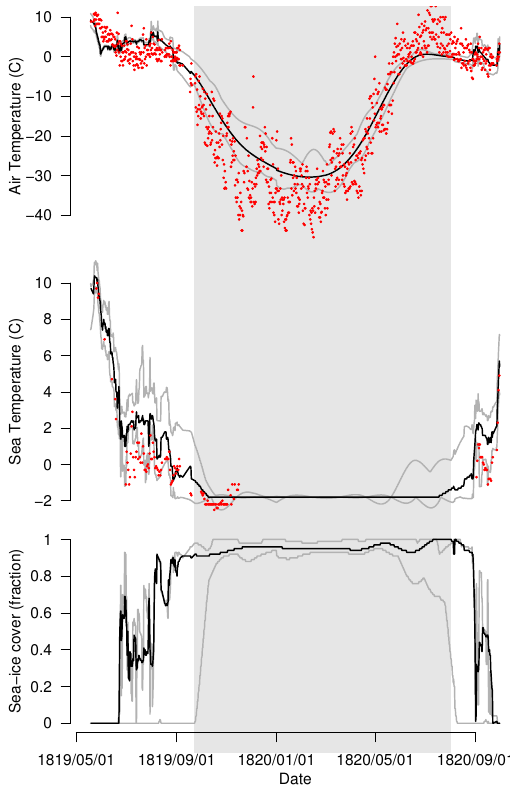
Fig.6. WeatherobservationsfromHMS Hecla in1819–20,comparedwithmodernvalues.Theredpointsaretheexpedition’sobservations, theblackandgreylinesarethemean,maxandminvaluesfrommoderndatasets(monthlyaveragesinterpolatedtodaily,1979-2004;SST Fig. 6. Weather observations from HMS Hecla in 1819–1820, com- andsea-icefromRayneretal.(2003),ATfromRigoretal.(2000),andpressurefromAllanandAnsell(2006)). Thegreybandmarksthe pared with modern values. The red points are the expedition’s ob- periodtheexpeditionspentinwinterharbour. servations, the black and grey lines are the mean, max and min val- ues from modern datasets (monthly averages interpolated to daily, 1979–2004; SST and sea-ice from Rayner et al., 2003, AT from Rigor et al., 2000, and pressure from Allan and Ansell, 2006). The grey band marks the period the expedition spent in winter